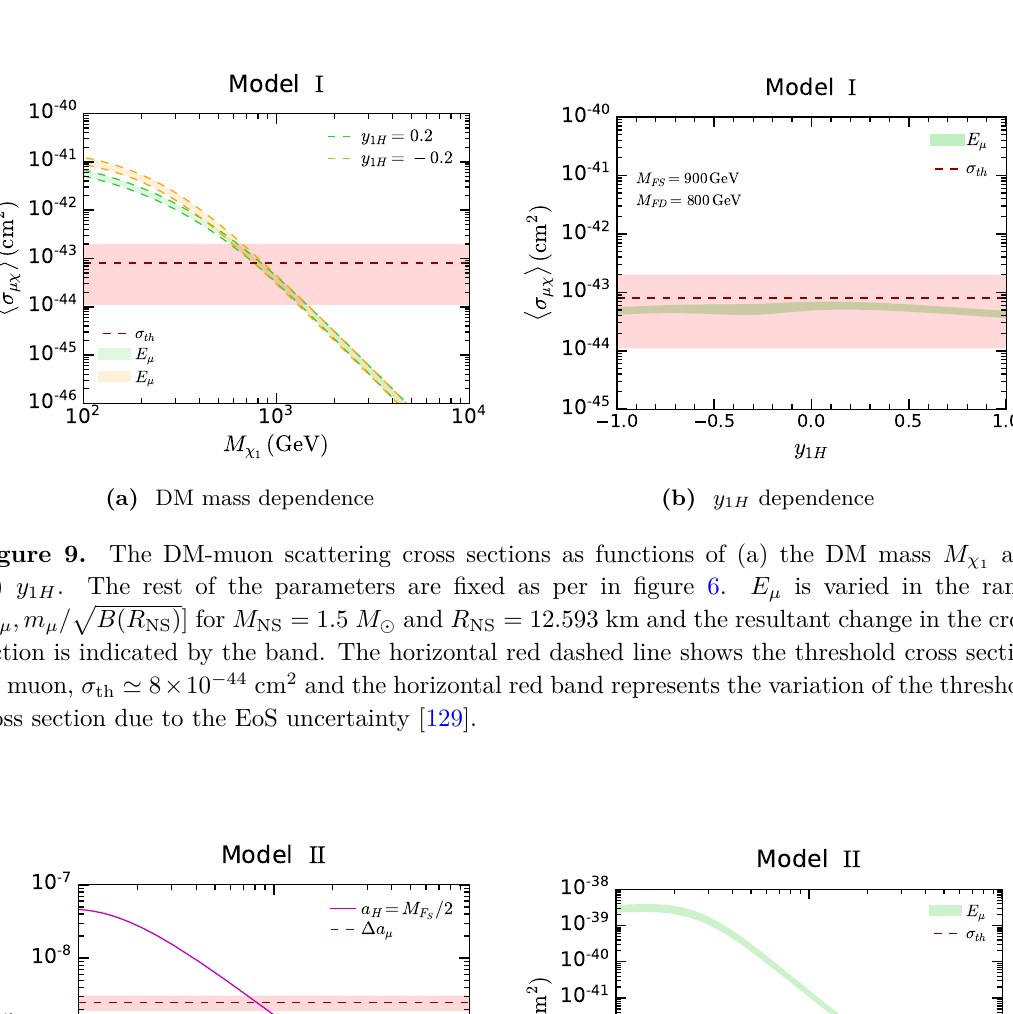
Figure 10. (a) ∆ a µ as a function of the DM mass M F . The horizontal dashed line indicates S the measured value of ∆ a µ , with its error indicated by the red band. (b) DM-muon scattering cross section as a function of the DM mass M F . E µ is varied in the range [ m µ , m µ / B ( R NS )] for S M NS = 1 . 5 M (cid:12) and R NS = 12 . 593 km and the resultant change in the cross section is indicated p by the band. The horizontal red dashed line shows the threshold cross section for muon, σ th ’ 8 × 10 − 44 cm 2 and the horizontal red band represents the variation of the threshold cross section due to the EoS uncertainty [129]. We set M ˜¯ /M F = 1 . 1 , M ˜ /M F = 1 . 2 , a H = M F / 2 , and e L S S S y 1 = y 2 = λ L = λ ¯ e = λ 0 = 0 . 5 L